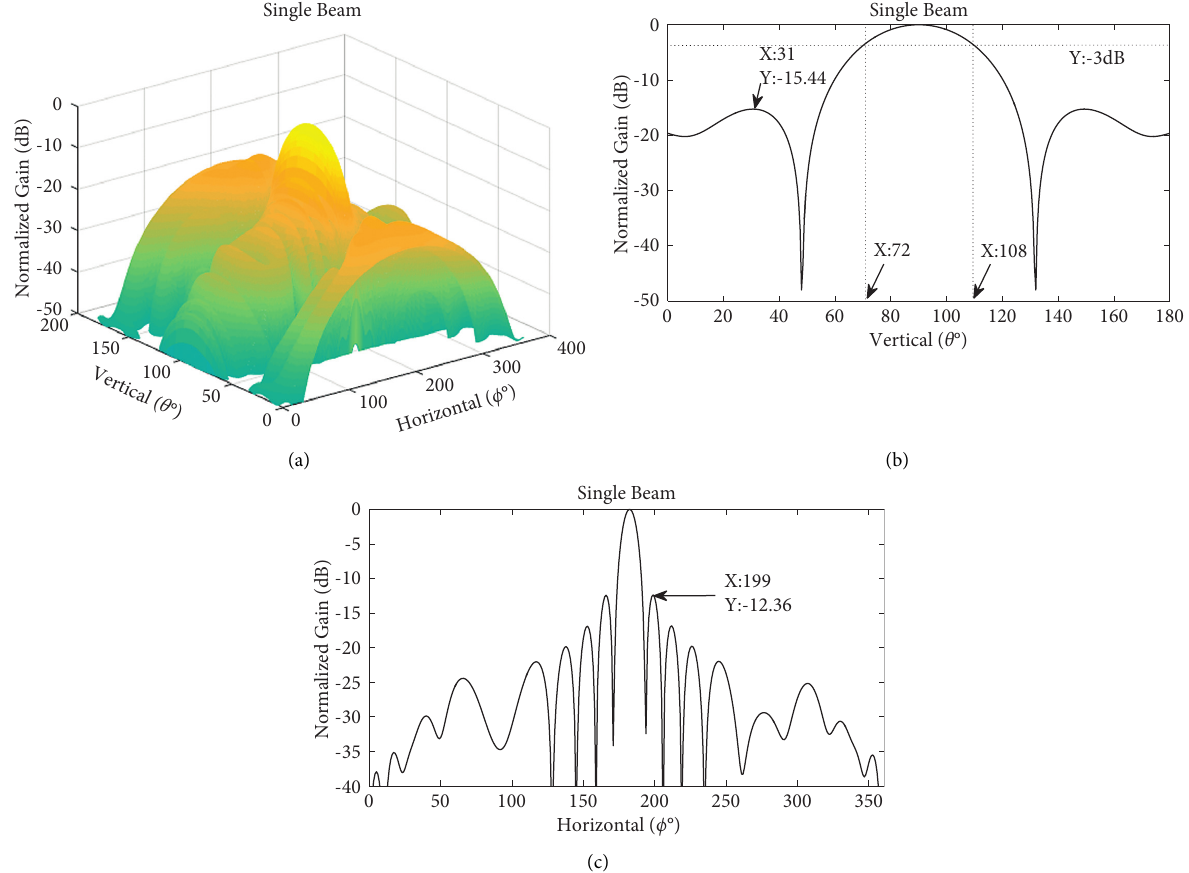
Figure 4: Pattern synthesis of cylindrical conformal array antenna: (a) 3D view, (b) elevation view, and (c) horizontal view.